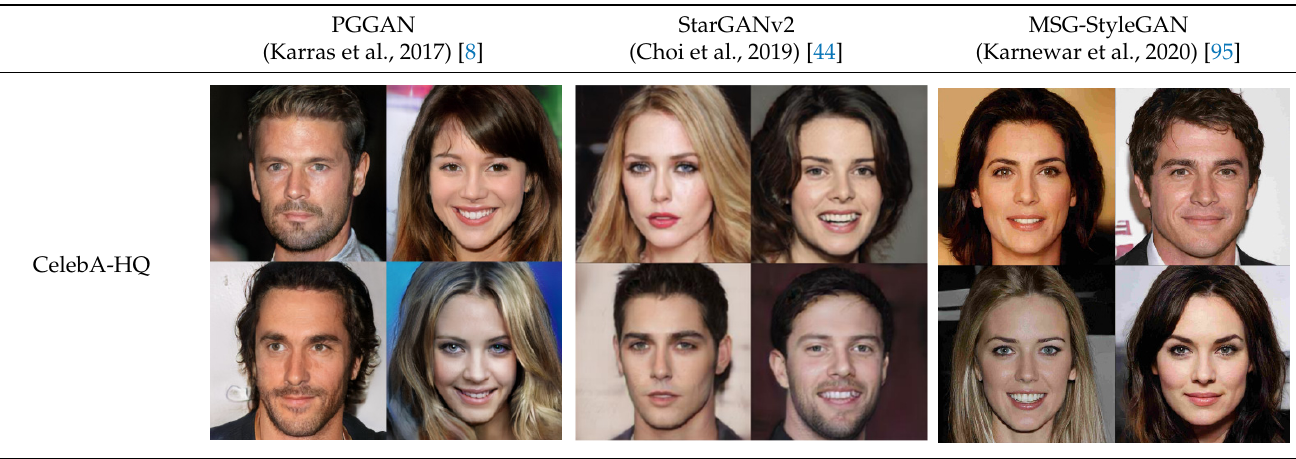
Table 5. Visual results of different models trained with the CelebA-HQ higher resolution image dataset. More results are presented in that paper.